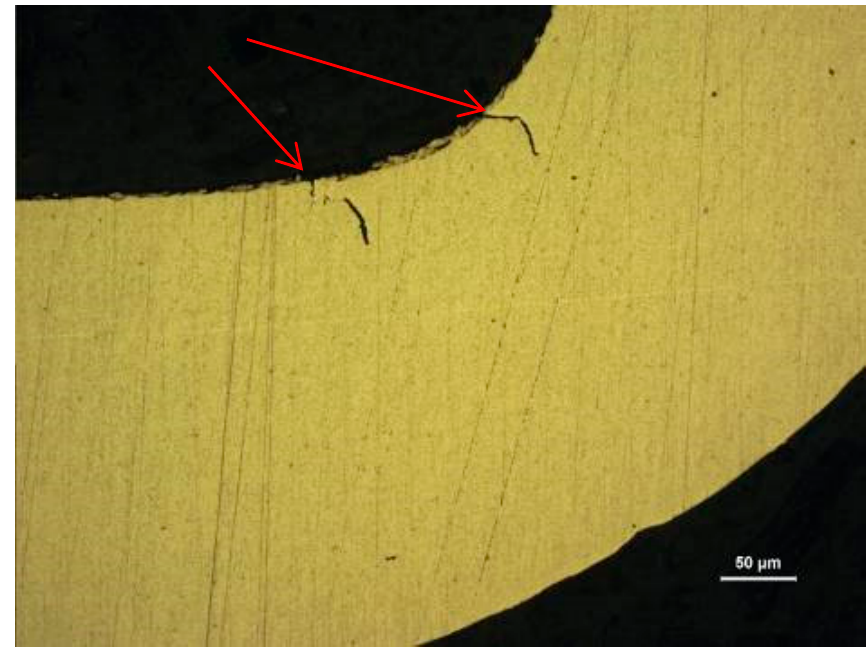
Figure 14. Cracks located on the angle of two adjacent pockets.